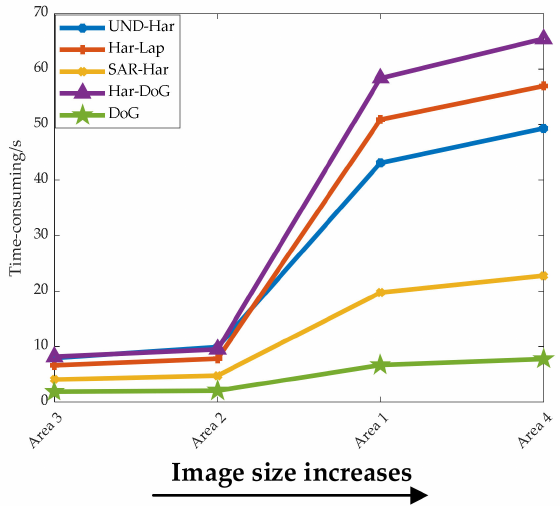
Figure 14. Time-consuming of five